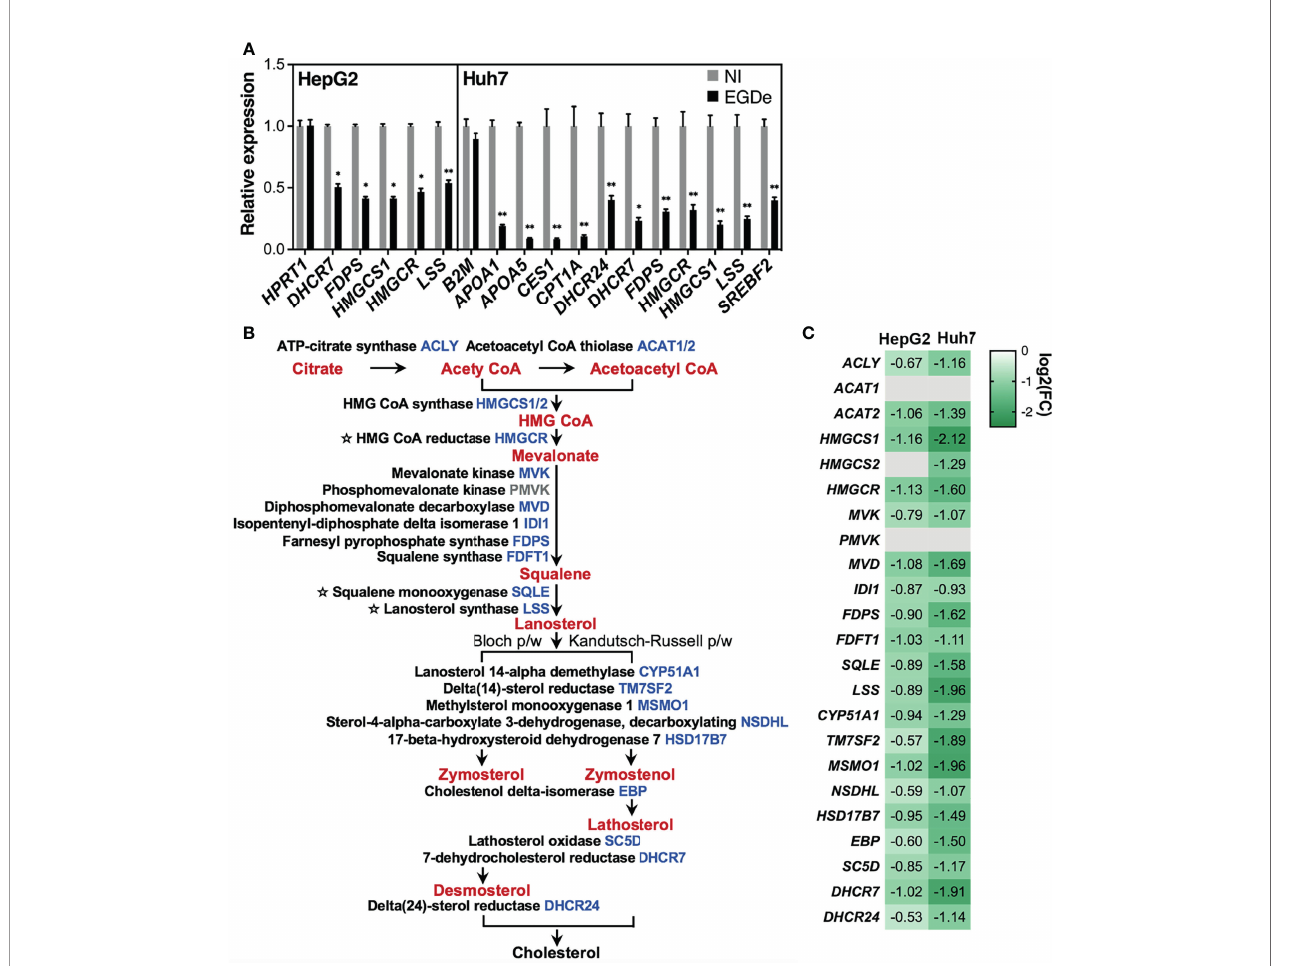
FIGURE 7 | Long-term Listeria infection downregulates almost all genes of the cholesterol biosynthesis pathway in both human HepG2 and Huh7 cells. (A) RT- qPCR analysis of transcript levels of representative genes involved in cholesterol metabolism and homeostasis in EGDe-infected HepG2 and Huh7 cells, relative to non-infected (NI) cells. Expression was normalized to YWHAZ or PPIA for HepG2 and Huh7 cells, respectively, and a non-differentially expressed control gene ( HPRT1 for HepG2, B2M for Huh7) is included. Values represent mean ± SD (n=3). Statistical signi fi cance, Student ’ s t test (* p < 0.05, ** p < 0.01). (B) Diagram illustrating the de novo cholesterol biosynthesis pathway. Enzyme names are in black and their corresponding gene symbols are blue when downregulated in infected cells, otherwise they are gray. Rate limiting enzymes are preceded by a star. Intermediary molecules are shown in red. Lanosterol can be transformed into cholesterol via two different routes: the Bloch pathway (left) and the Kandutsch-Russell pathway (right). (C) Heat map showing the log2 FC obtained by RNA-seq in HepG2 and Huh7 infected versus NI cells, for each of the cholesterol synthesis enzyme coding genes listed in (B)